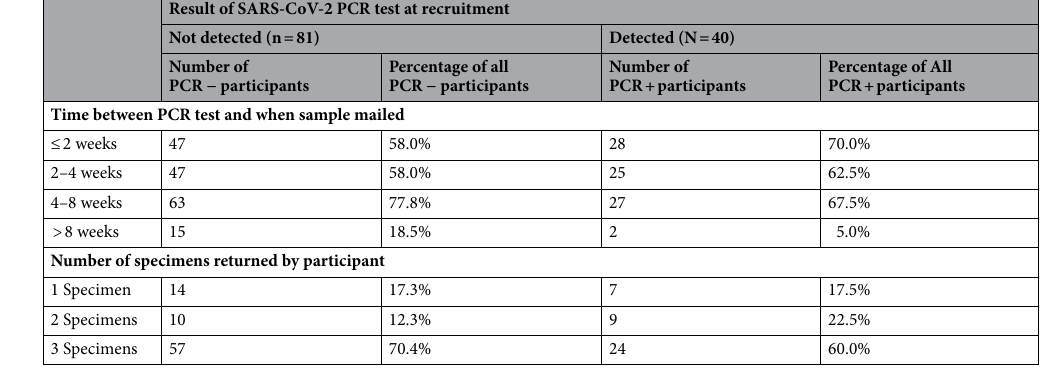
Table 2. Overview of received specimens. Table shows number of participants who returned a specimen within the indicated time after a PCR test for SARS-CoV-2. Additionally, numbers of participants returning the indicated number of specimens are